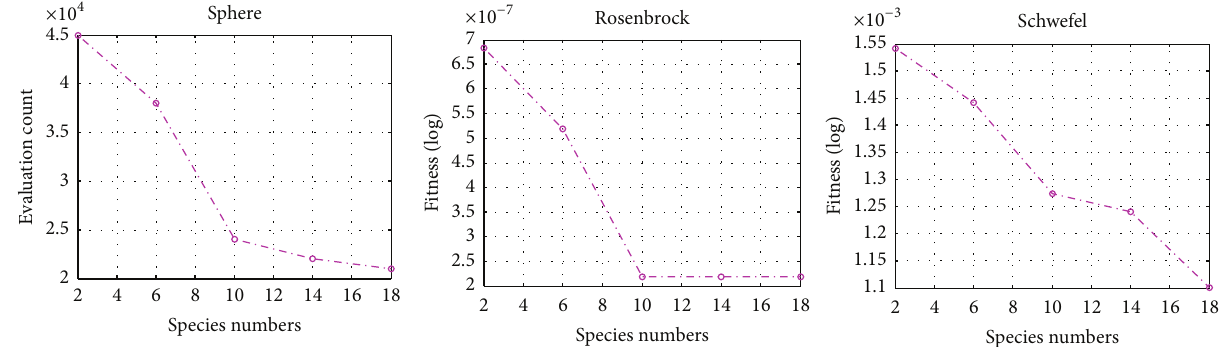
Figure 5: Results on test functions with different species number 𝑁